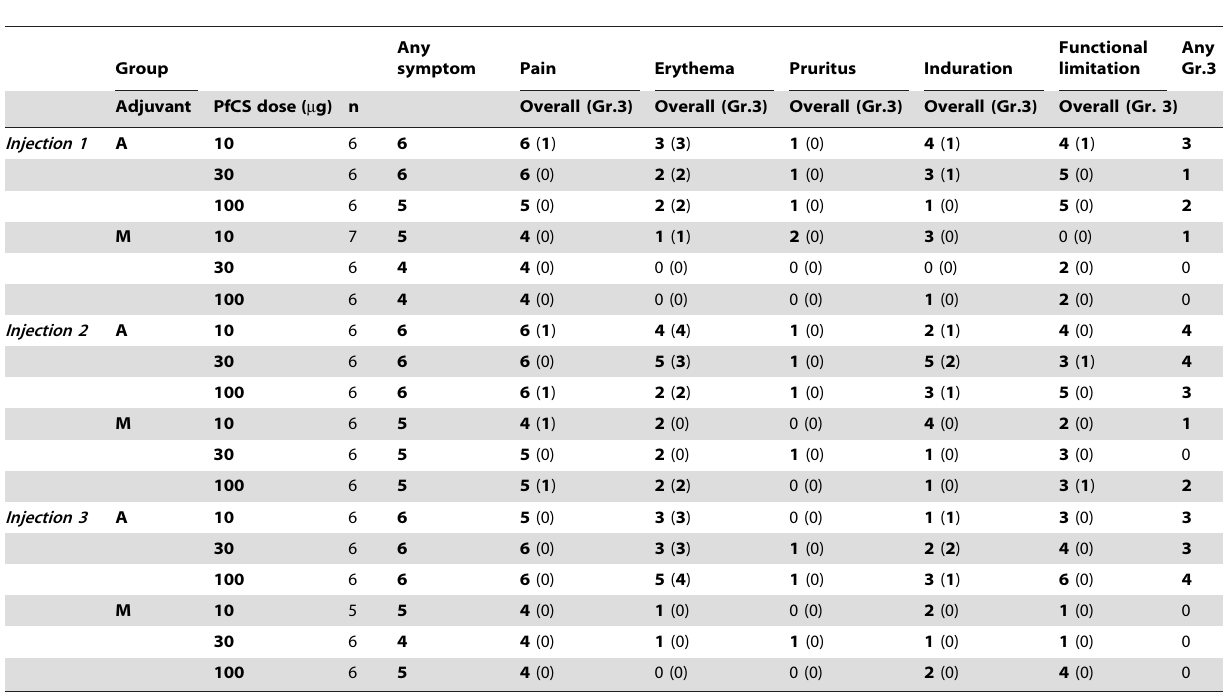
Table 2. Local adverse events during the 4-day follow-up after each immunization.